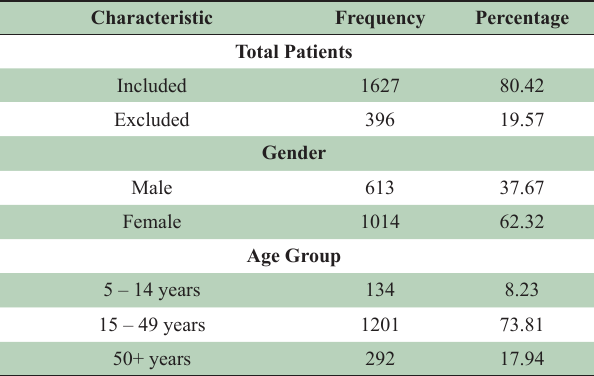
Table-I: Demographics: